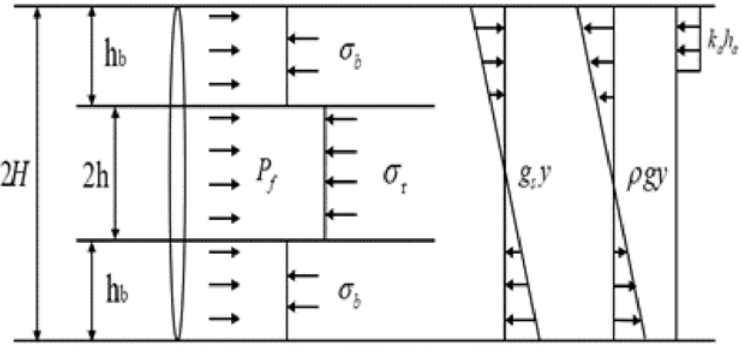
Figure 4. Fracture wall stress distribution.